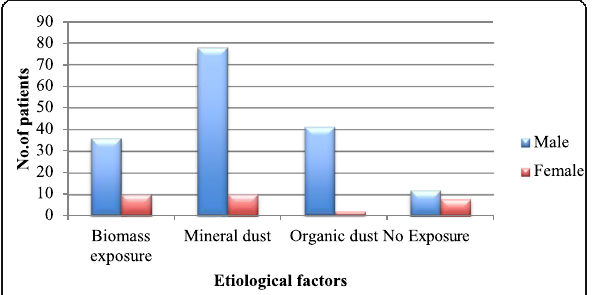
Fig. 9 Distributional occupational exposure with gender